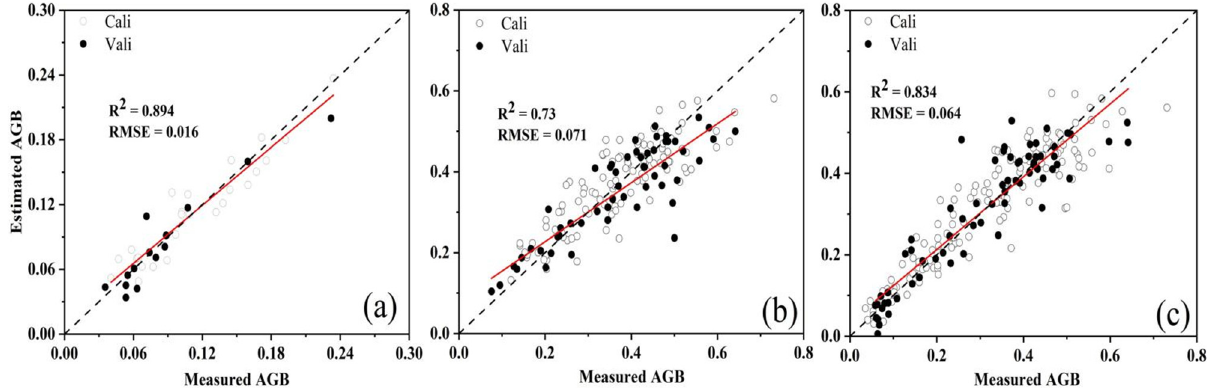
forming effective wavelengths vs. AGB for the following stages: ( a ) seedling, ( b ) post-seedling, ( c ) all stage.